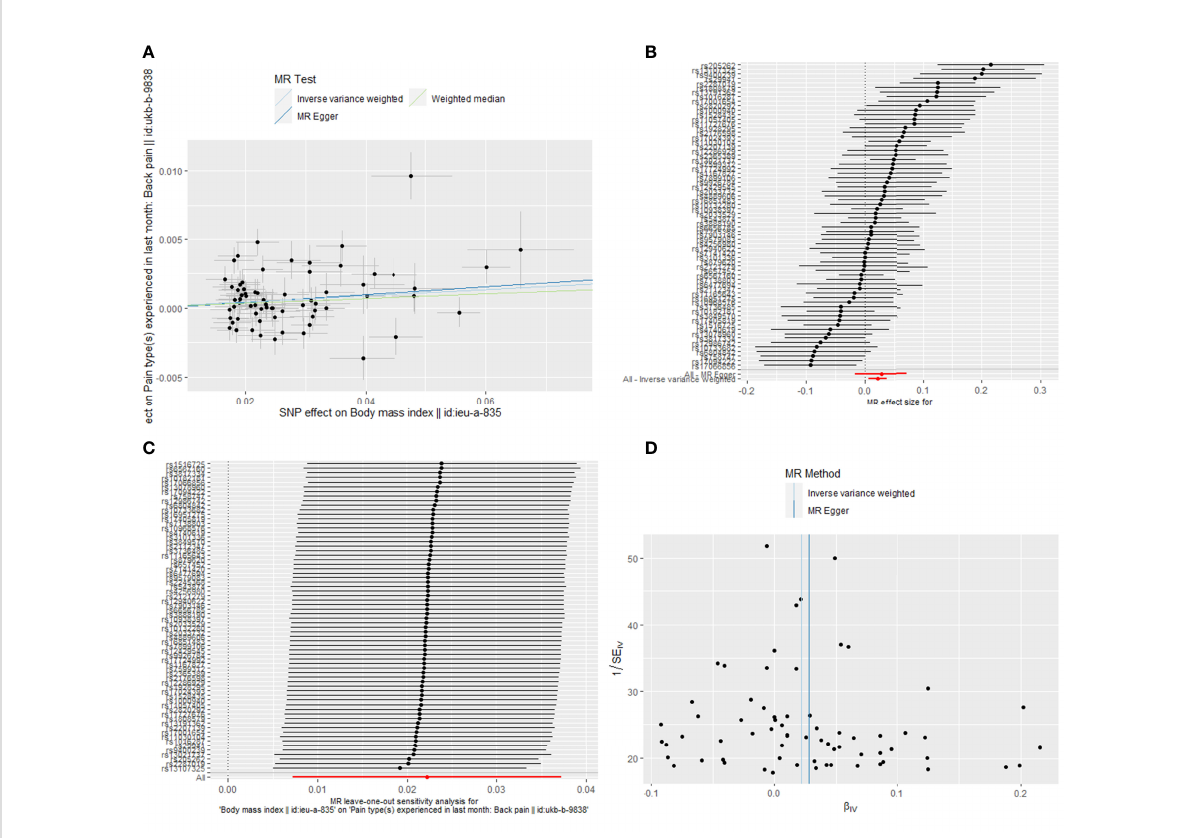
FIGURE 4 The Mendelian randomization analysis for causal effects of body mass index on back pain. (A) Scatter plot about the causal effect of body mass index on back pain. (B) Forest plot for the overall causal effects of body mass index on back pain. (C) Leave-one-out analysis for the causal effect of body mass index on back pain. (D) Funnel plot of SNPs related to body mass index and back pain. SNPs, single-nucleotide